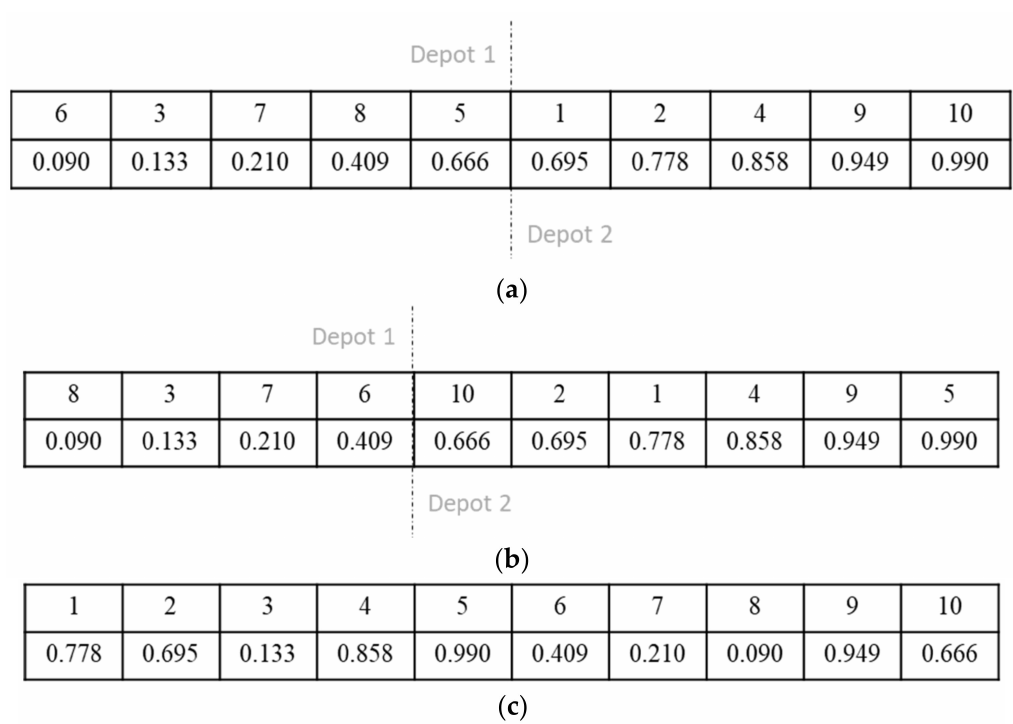
Figure 7. Neighborhood search translation. ( a ) Before NSP; ( b ) After NSP; ( c ) Translated NSP. Neighborhood search translation returns NSP10 to the initial customer id {1, . . . ,| N